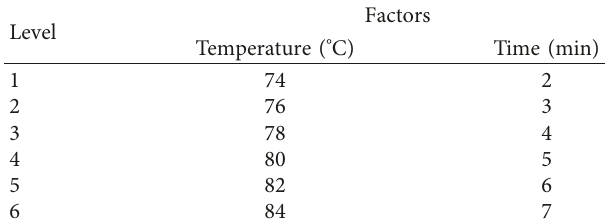
Table 3: Orthogonal experiments on temperature and heating time of